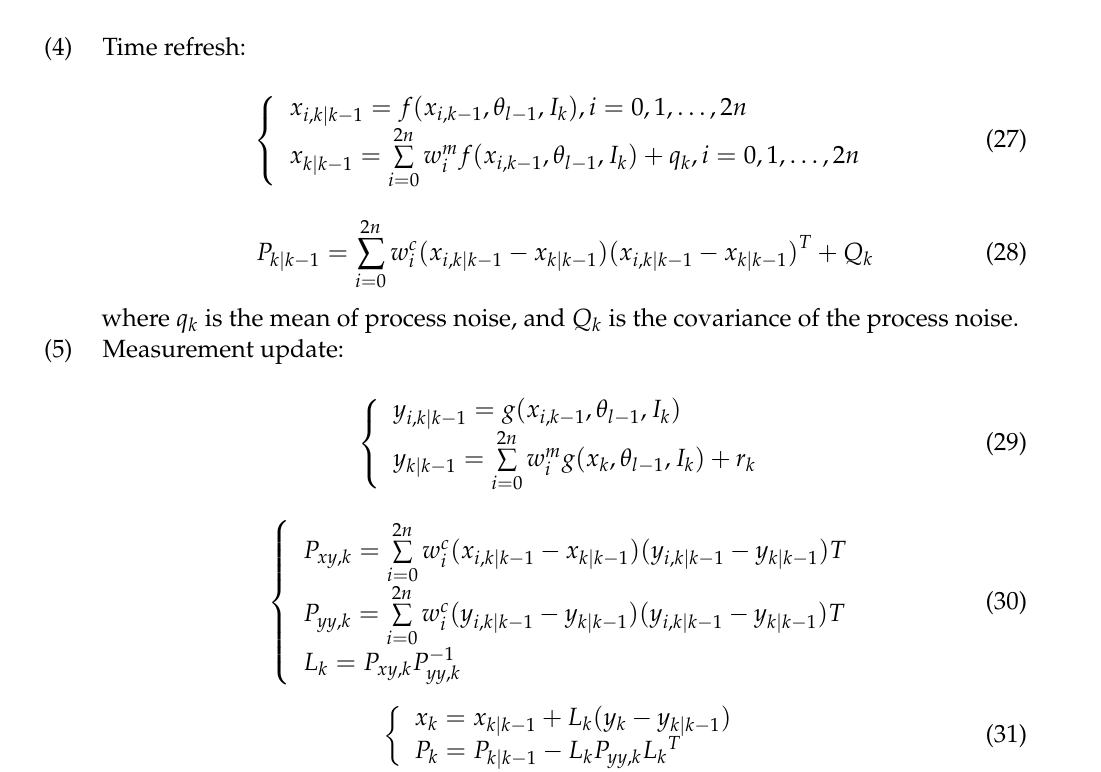
Figure 10. The error curves of UKF and DUKF . It is not difficult to find the voltage prediction error of DUKF being less than the offline UKF. The DUKF calibrates error in a very short time, and thus the robustness of the DUKF is better than UKF. The result demonstrates the superiority of the online DUKF. 4.2. Improved DUKF In Section 3, the IHHO is proposed, and now is used to find the optimal initial pa- rameters for DUKF, such that the